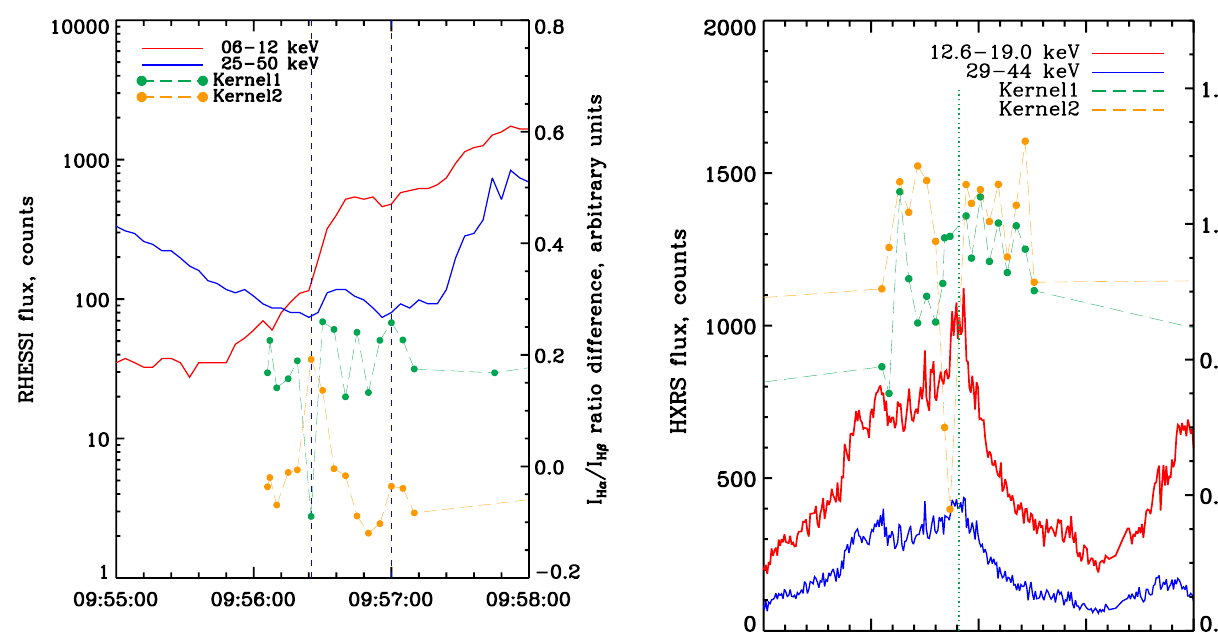
Fig. 8. Temporal evolution of HXR from RHESSI and the differ- ence between the H α /H β ratio values in the line center and at the distance 0.5 ˚A from the line centre. The vertical dashed lines mark the beginning and end of the HXR burst.